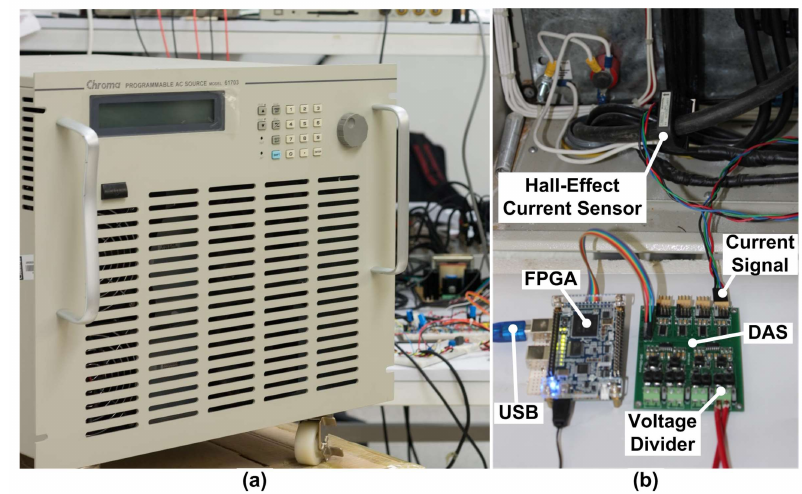
Figure 5. Experiment setup for assessing the detection and classification of PQD utilizing the proposed field programmable gate array (FPGA)-based methodology. ( a ) Programmable alternating current (AC) power source form Chroma Systems solutions. ( b ) Voltage/current signal acquisition.